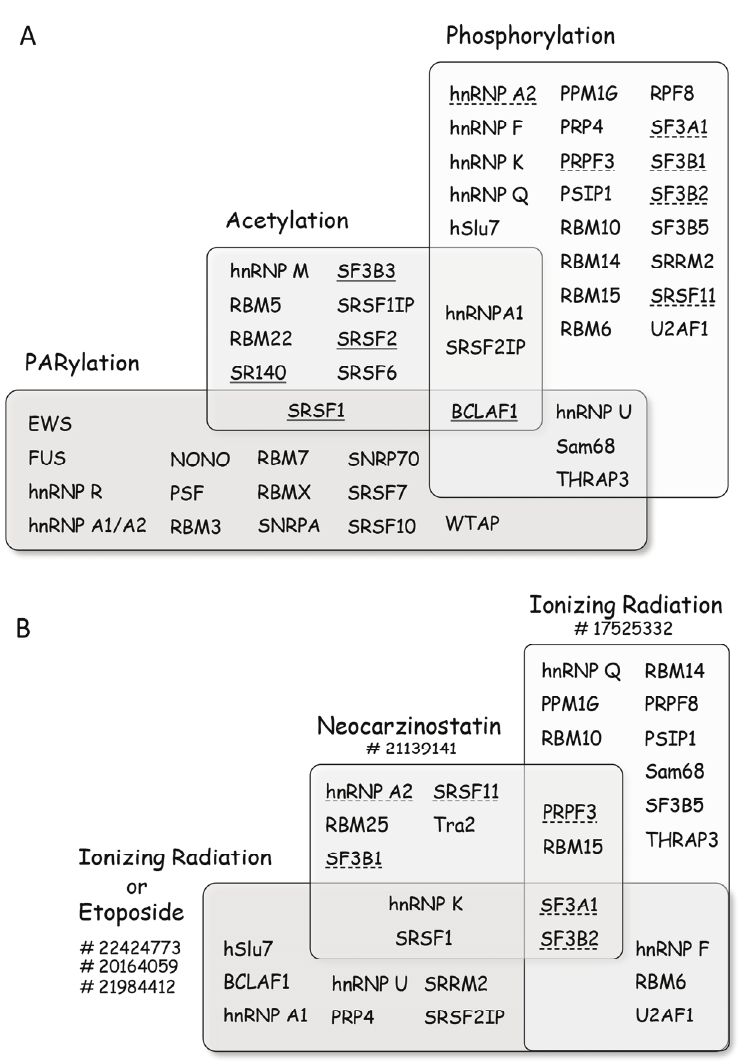
Figure 4. Post-translational modifications of splicing factors promoted by DNA damage. ( A ) Diagram representing splicing factors that are modified upon treatment of cells with genotoxic agents. The list is non-exhaustive and more factors can be found in the references given in the text. Splicing factors are grouped according to the type of modifications they sustain, with BCLAF1 being subjected to all three types of modifications. When DNA damage elicits deacetylation the name of the splicing factor is underlined, whereas a dashed underline indicates dephosphorylation; ( B ) Diagram representing the impact of selected treatments on the phosphorylation/dephosphorylation of splicing factors (a dashed underline indicates dephosphorylation), with SF3A1 and SF3B2 being dephosphorylated in all groups of treatments. PubMed Identification (PMID) numbers for the different studies are indicated next to treatments. The impact of other agents on specific factors is discussed in the